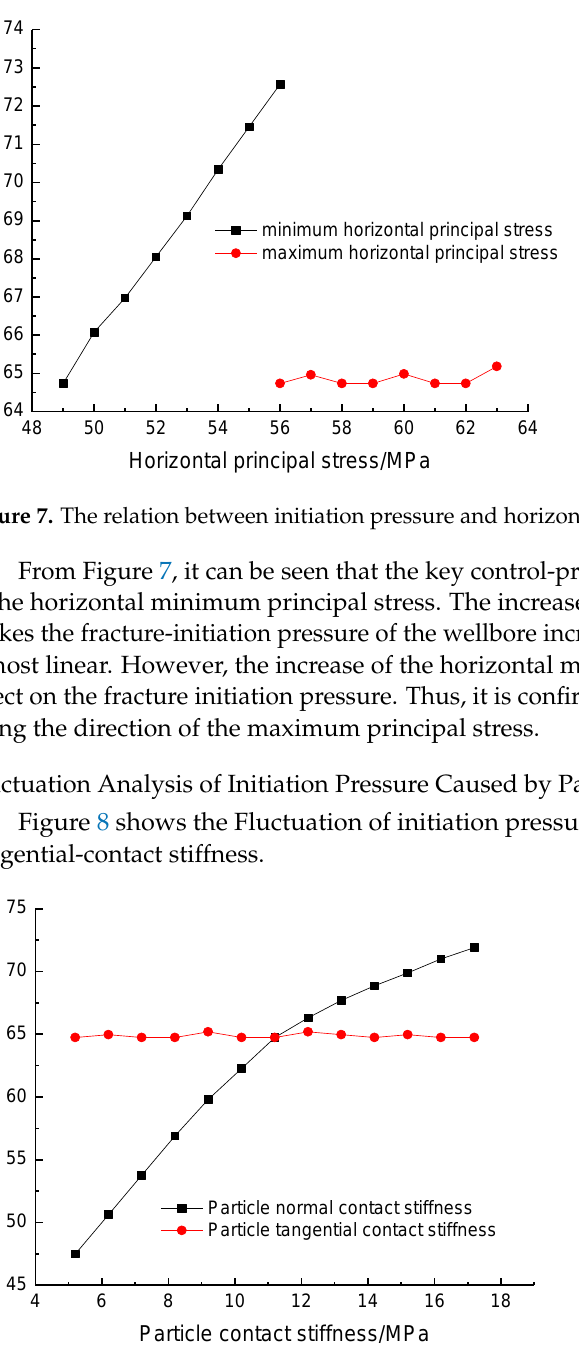
Figure 8. The relation between initiation pressure and particle-contact stiffness. From Figure 8, it can be seen that the fracture initiation in hydraulic fracturing is mainly caused by tensile failure. Near the wellbore, the increase of wellbore pressure first causes the hoop stress around the wellbore to reach the failure extreme, thus the fractures form a radial-spread